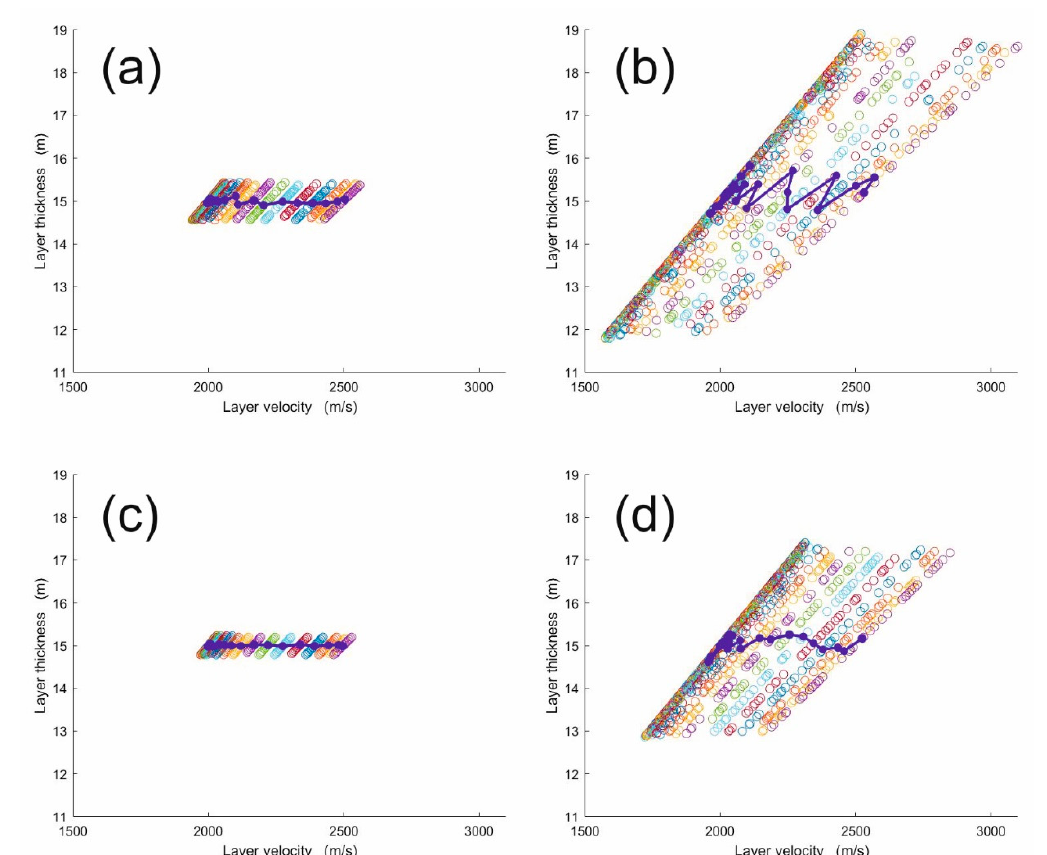
Figure 4. The circles present the estimated layer velocity and thickness obtained by perturbing randomly the input data in different ways. Dots with the same color correspond to the same perturbed offset along the profile over the model in Figure 3. The correct thickness is 15 m, while the velocity ranges from 2000 to 2500 m/s. The thick blue line joins the averages of the perturbed offsets in each line. The perturbations are ( a ) the offset, up to 1%; ( b ) the intrabed multiple, up to 0.01% with a 2.5 m offset, ( c ) with a 10 m offset, and ( d ) with 0.1% perturbation but still with a 10 m offset.